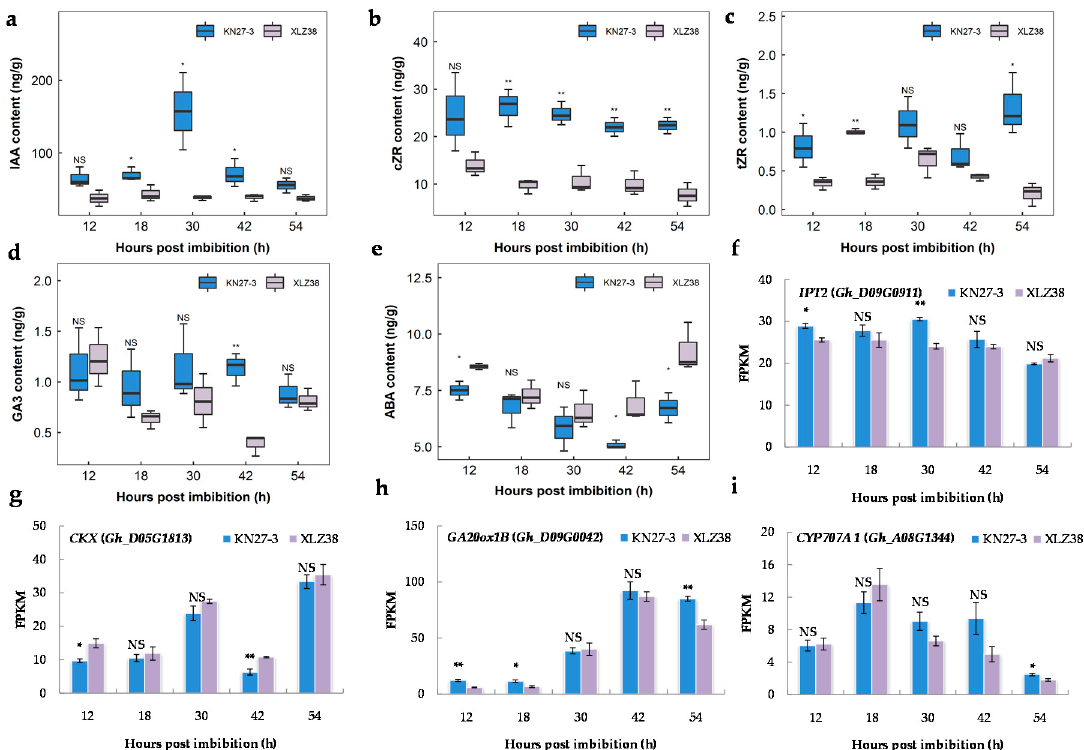
Figure 7. Endogenous hormone contents in KN27-3 and XLZ38 and the expression of the genes related to hormone metabolism during cottonseed germination. ( a ) IAA, ( b ) cZR, ( c ) tZR, ( d ) GA3, ( e ) ABA, ( f ) IPT2 , ( g ) CKX , ( h ) GA20ox1B , ( i ) CYP707A1 . Y-axis values are the means of three independent replicates ± SE. The internodes in the same hour act as a comparison. Differences are indicated by “*”, “NS” represents no difference.